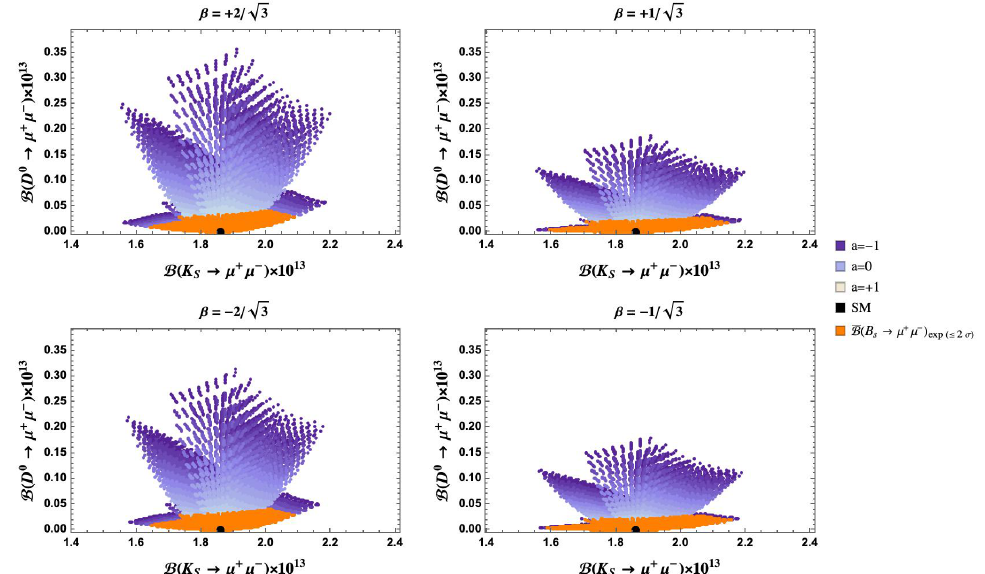
Figure 13 . Correlation between B ( D 0 → µ + µ − ) and B ( K S → µ + µ − ) in 331 models with pa- rameters as in figure 8. The black dot represents the SM result. The orange points are obtained requiring B ( B + µ − ) in the experimental range within 2 σ s → µ